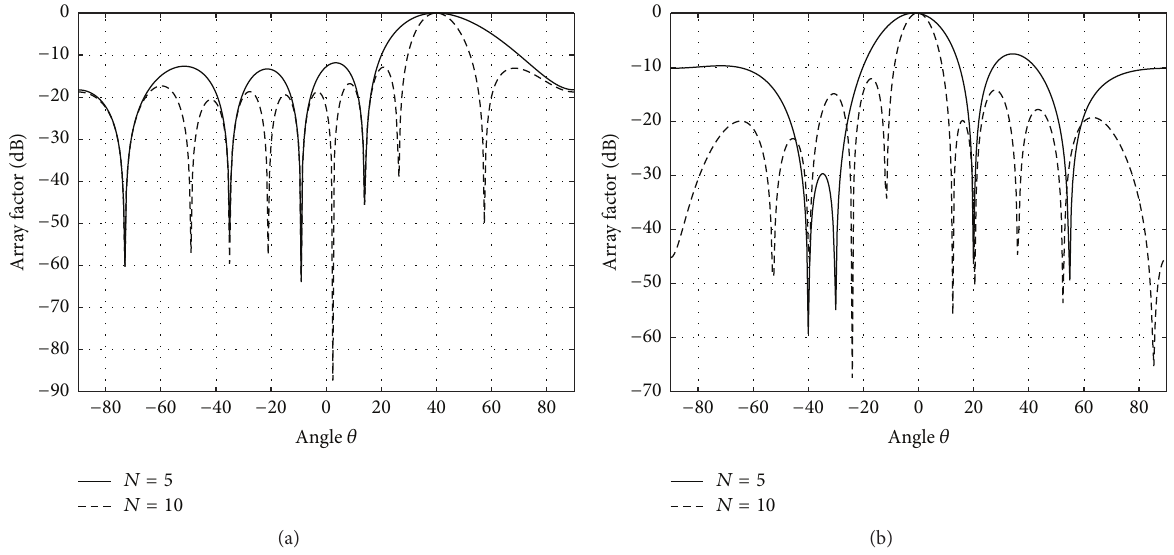
Figure 9: Comparison of the antenna arrays radiation pattern with 𝑁 = 10 and 𝑁 = 5 elements: (a) the angle of arrival of the desired signal is 40 ∘ and the angle of arrival of the interfering signal is − 35 ∘ ; (b) the angle of arrival of the desired signal is 0 ∘ and the angles of arrival of the interfering signals are − 40 ∘ and 20 ∘ .